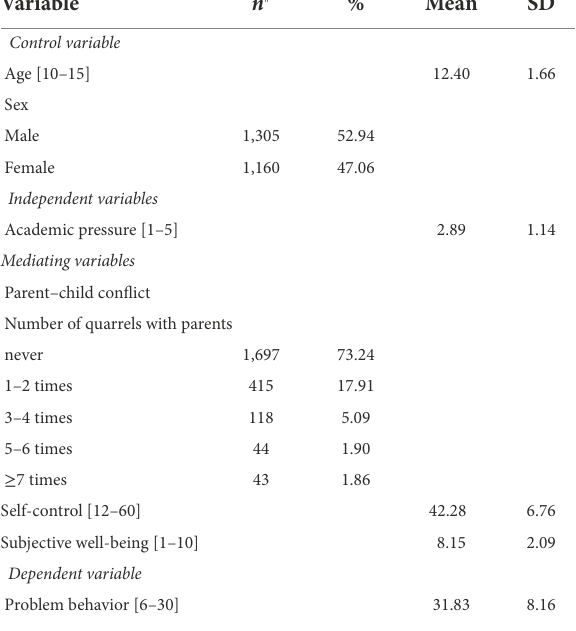
TABLE 1 Descriptive statistics variables of the sample ( n = 2,465).